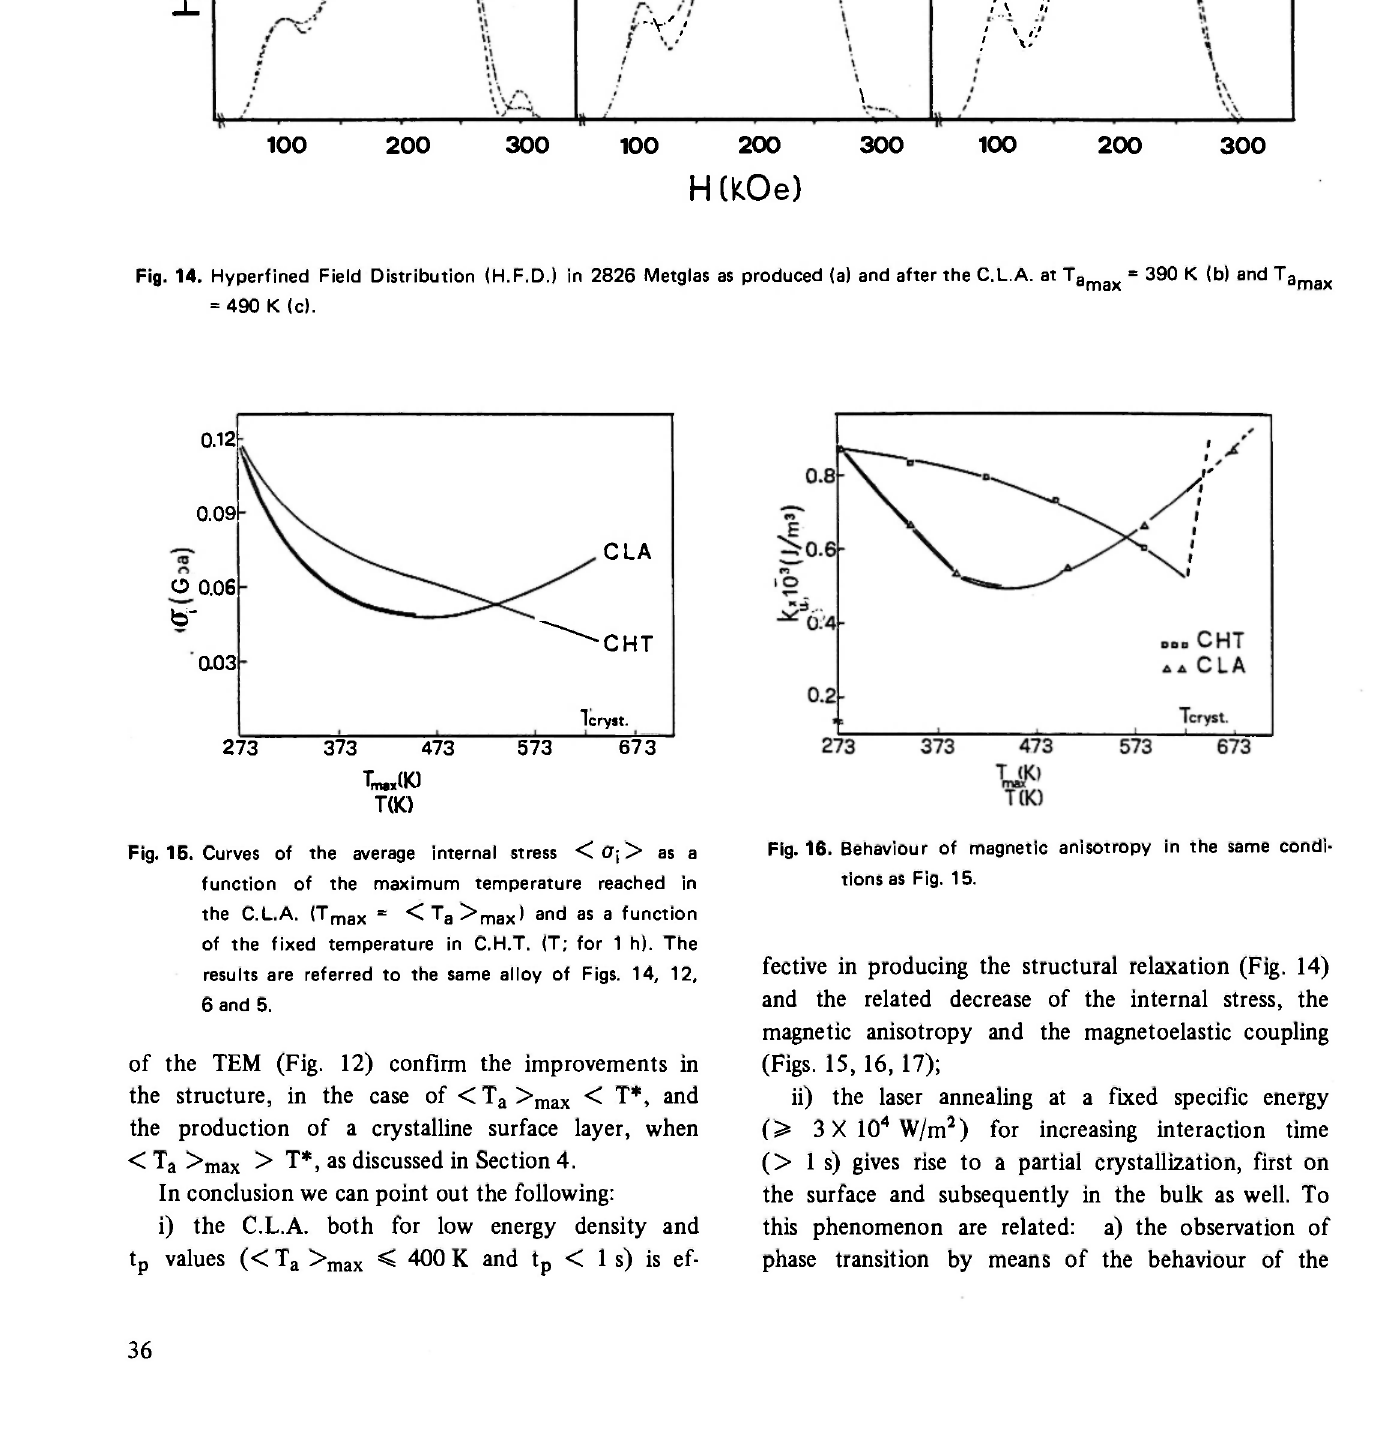
Fig. 14. Hyperfined Field Distribution (H.F.D.) in 2826 Metglas as produced (a) and after the C.L.A. at T amax = 390 Κ (b) and T 3 m ax = 490 Κ (c).